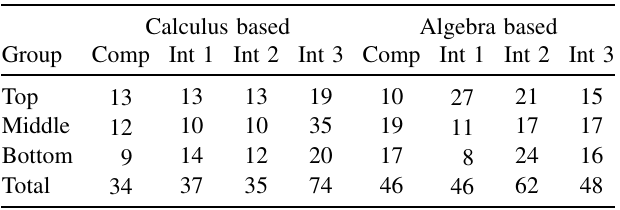
TABLE IV. The number of students in each group in the calculus-based course and algebra-based course, where ‘‘Comp’’ stands for ‘‘comparison’’ and ‘‘Int’’ stands for ‘‘intervention.’’